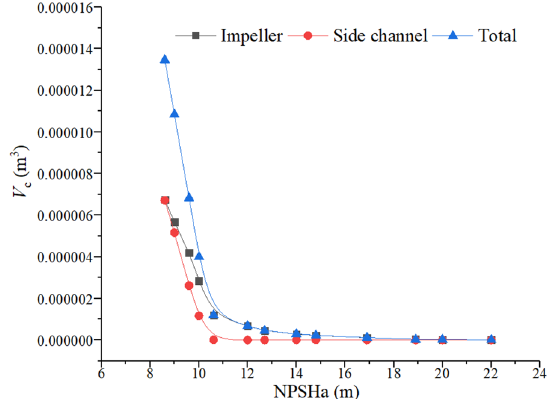
Figure 6 Variation of cavity volume at different NPSHa under the design